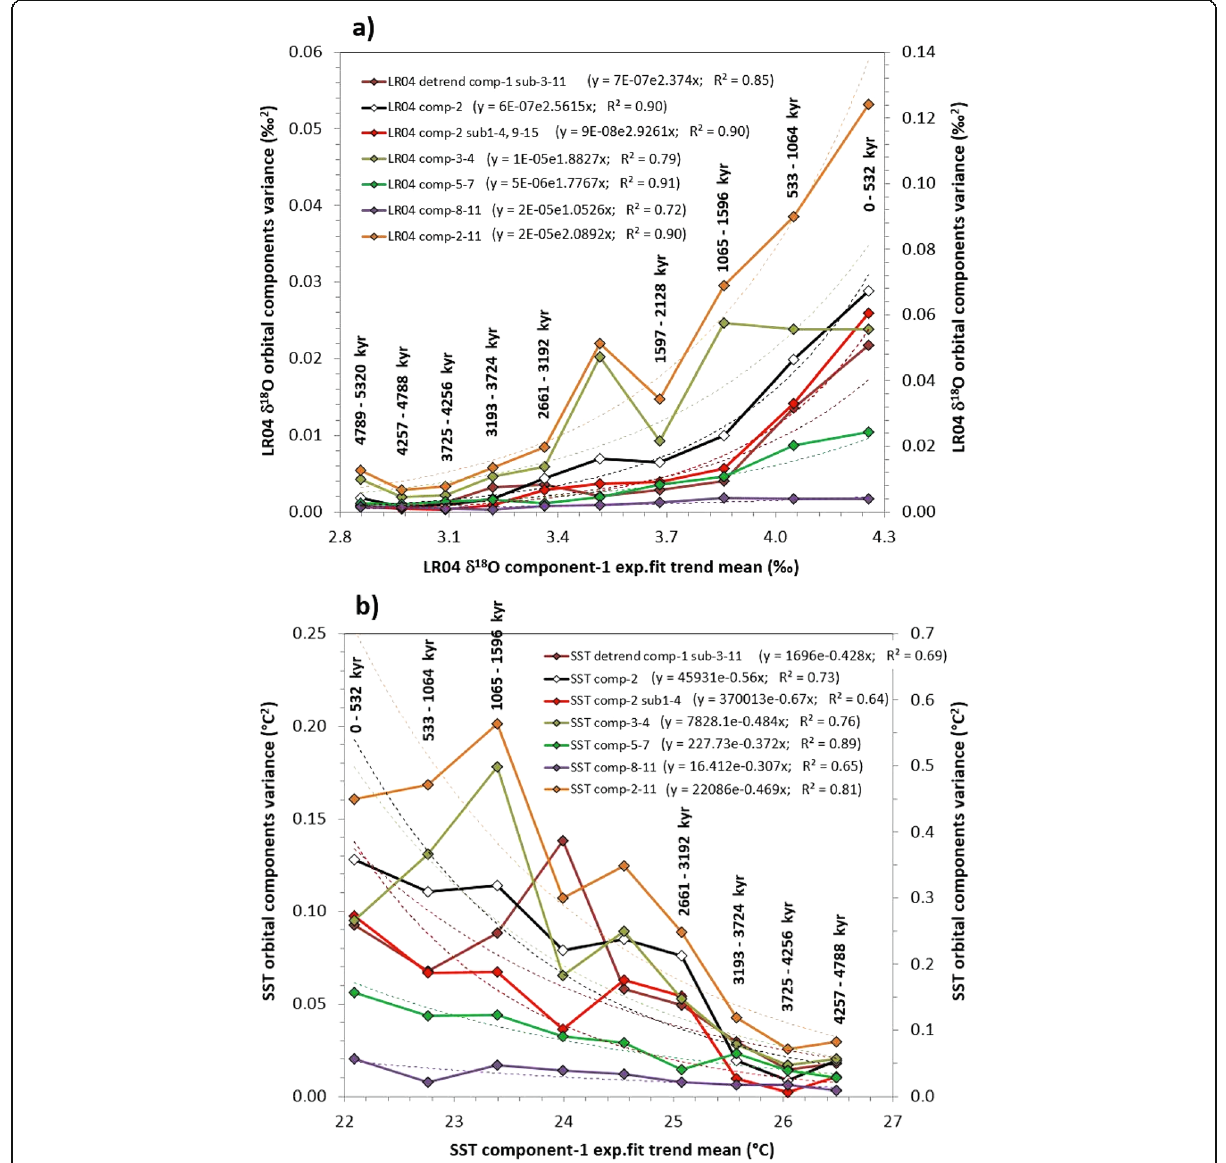
Fig. 10 Exponential relationships of the orbital variance of a δ 18 O components and b SST components vs. the average of component-1 exponential fit trends by time segments binned at 532 kyr. The right y -axis shows the variance of comp-2-11 (orbitals) with a different scale to not compress the left y -axis